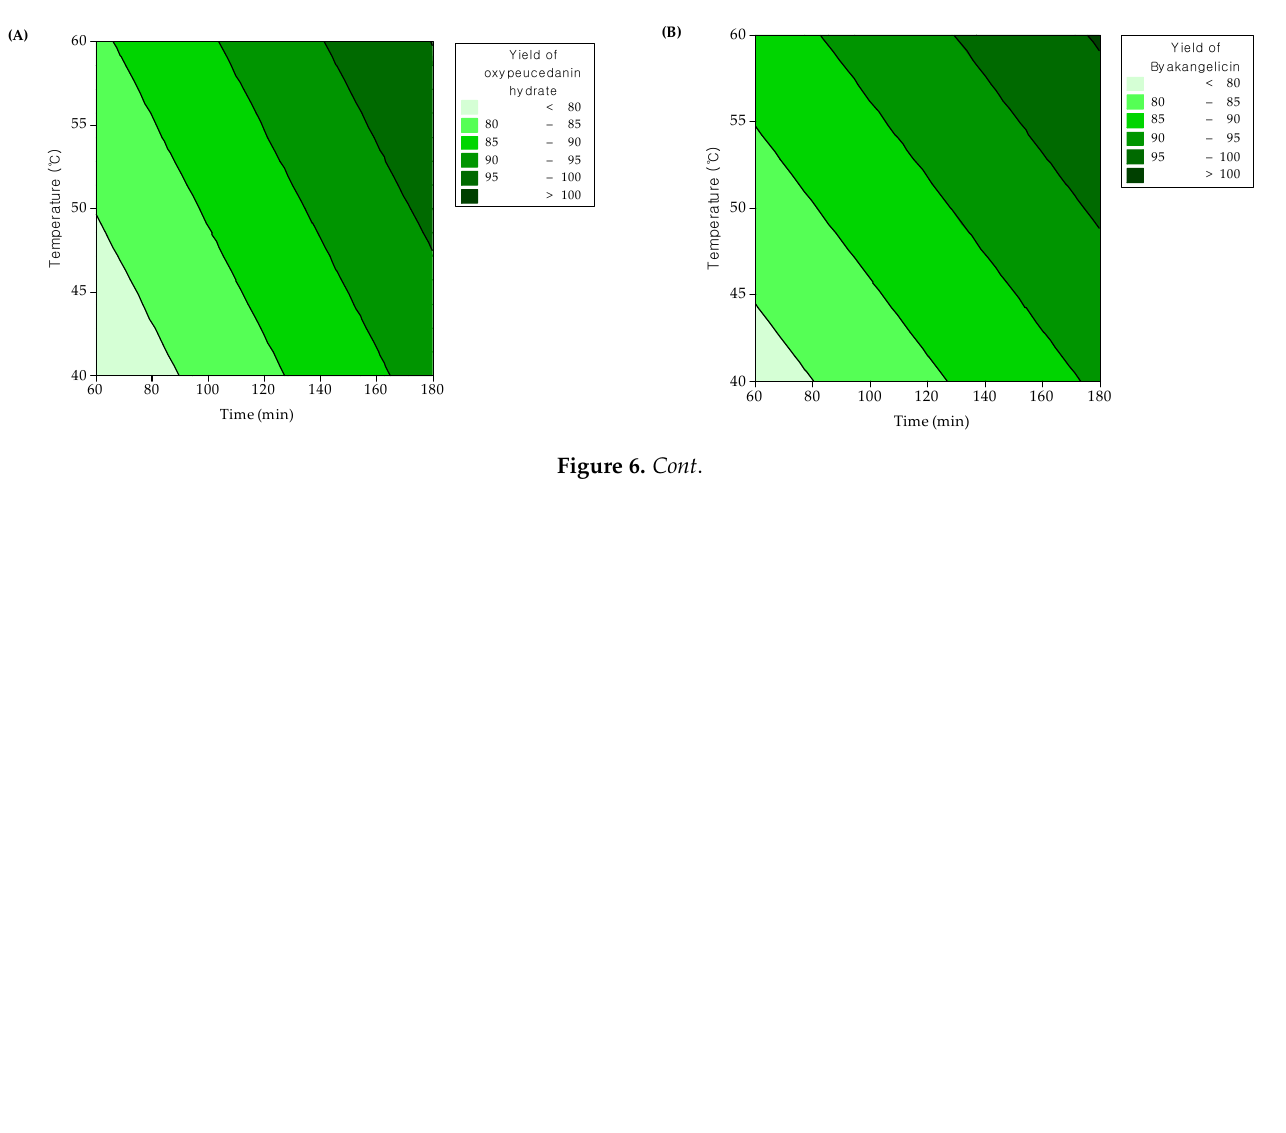
As seen in Table 3, sole linear term coefficients X 1, X 2, and X 3 were significant with p - our model. The “lack of fit”for p -values ( p = 0.23 for oxypeucedanin hydrate and p = 0.40 for byakangelicin) and the “lack of fit” for F-values (F = 3.58 for oxypeucedanin hydrate and F = 1.67 for byakangelicin) indicated that the model was significant and suitable for obtaining optimum extraction of oxypeucedanin hydrate and byakangelicin (Table 3). The second-order differential equations for obtaining oxypeucedanin hydrate and byakangelicin are illustrated below.